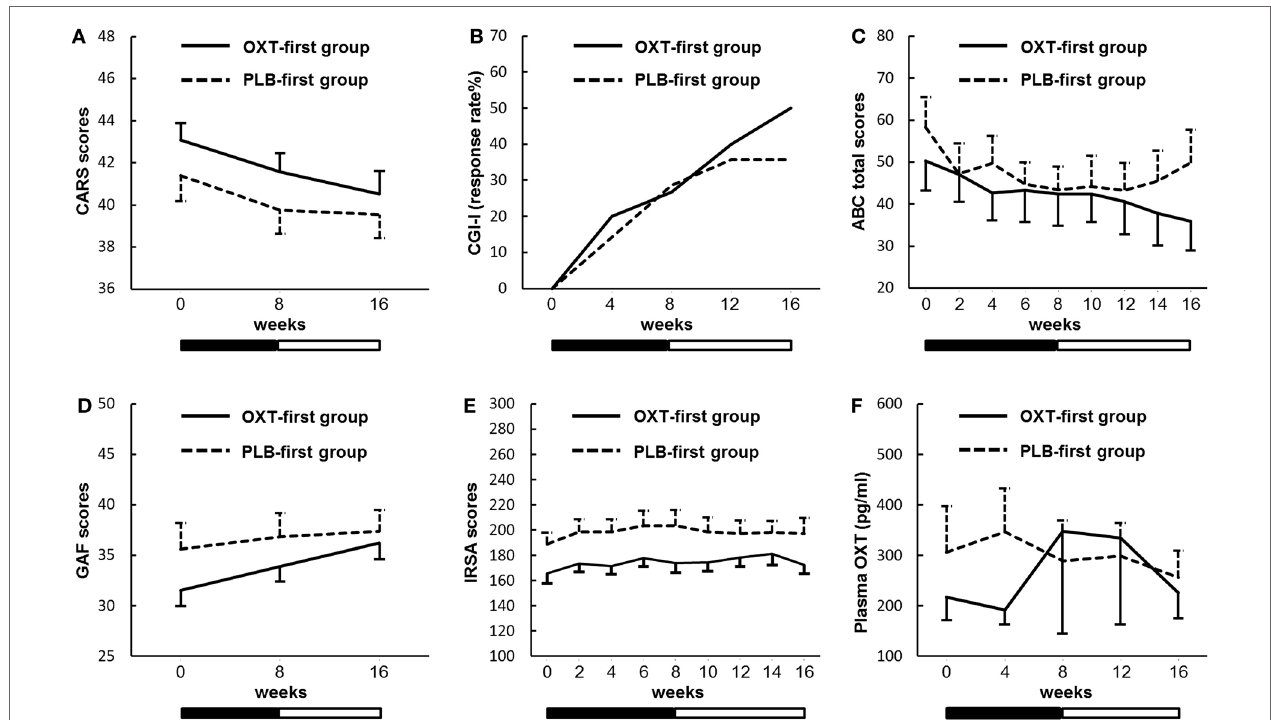
FigUre 3 | sequential changes in the outcome measures. (a) The Childhood Autism Rating Scale (CARS). (B) The Clinical Global Impressions – Improvement scale (CGI-I). (c) The Aberrant Behavior Checklist (ABC). (D) The Global Assessment of Functioning (GAF). (e) The Interaction Rating Scale Advanced (IRSA). (F) Plasma oxytocin (OXT) concentrations. Solid and dashed lines indicate the OXT-first and placebo (PLB)-first groups. Black and white bars indicate the first treatment period and second treatment period, respectively (8 weeks for each period). Error bars indicate the SEM values. Response rates in the CGI-I show the percentages of participants assessed at 1 (very much improved) or 2 (much improved). There were no significant main effects of the treatment on any of the outcome